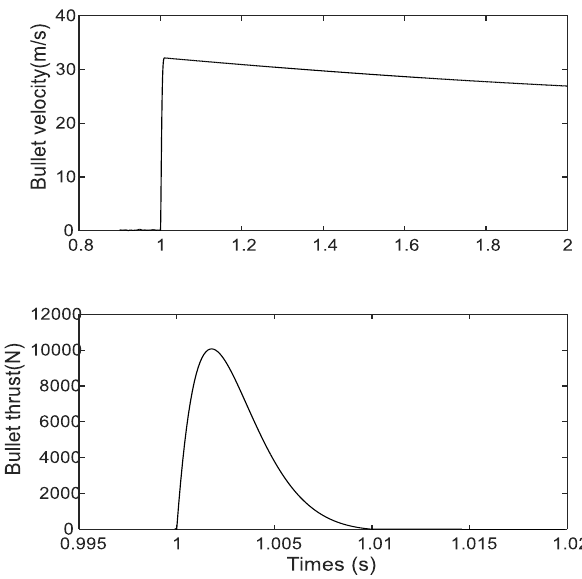
Figure 13. Internal fire-extinguishing ballistic response of the fire-extinguishing ball.